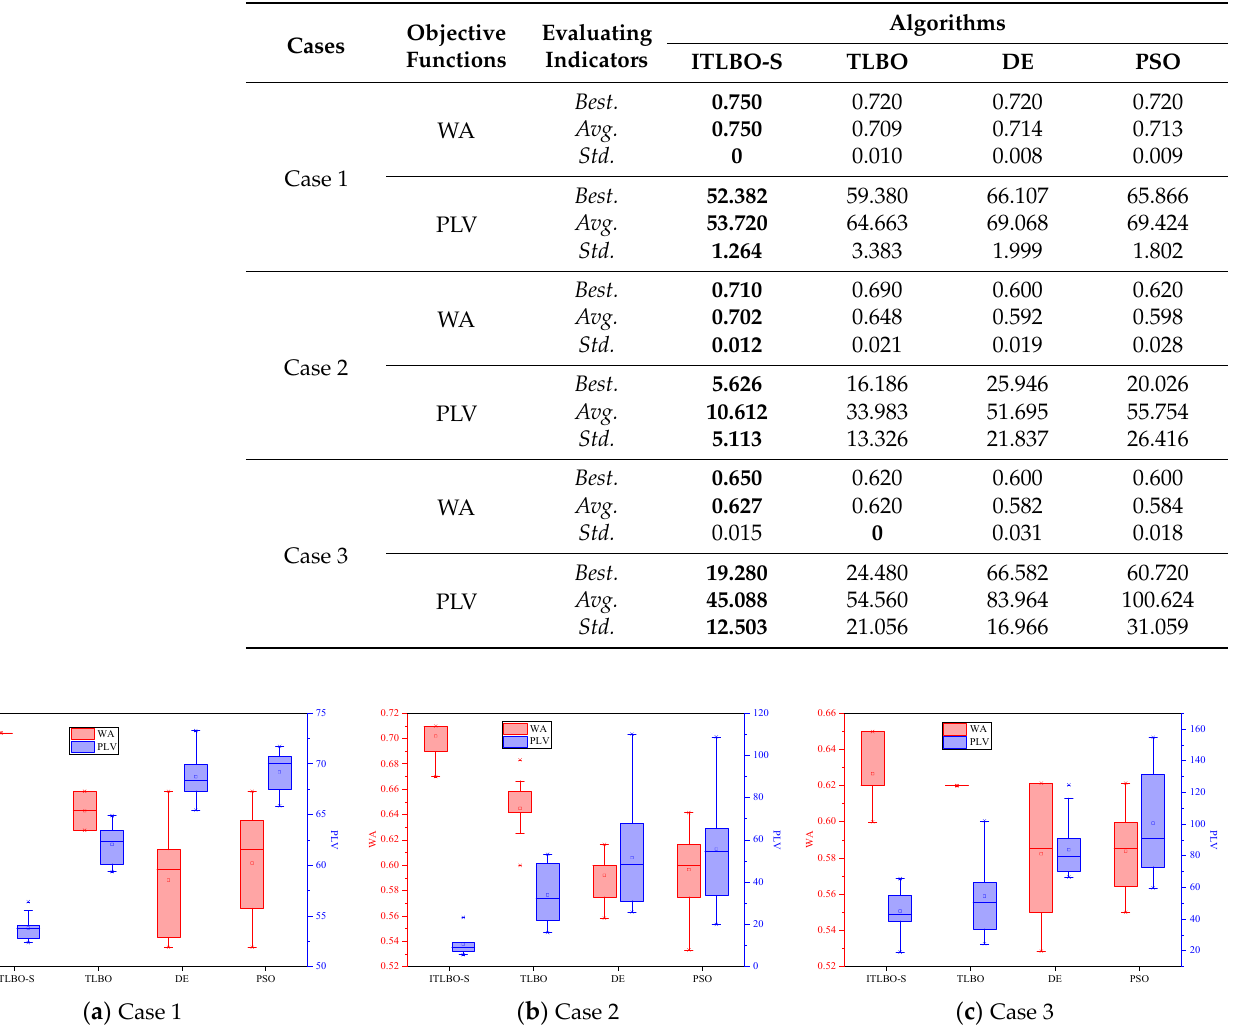
Figure 11. Box plot of the repeated calculation results.